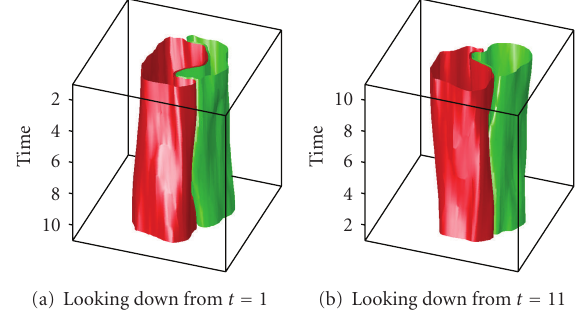
Figure 23: 3D representation of the segments.